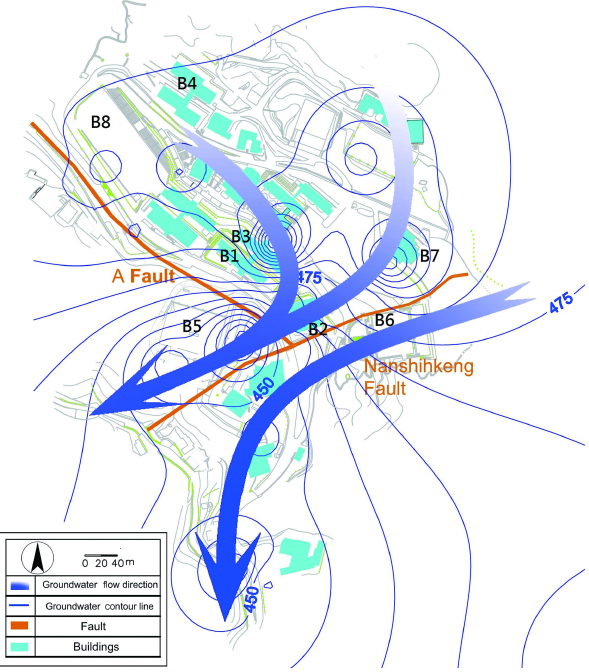
Figure 18. Flow directions of groundwater within the campus. The flow directions are inferred by the groundwater table drop, which is revealed by the contour of the groundwater table.